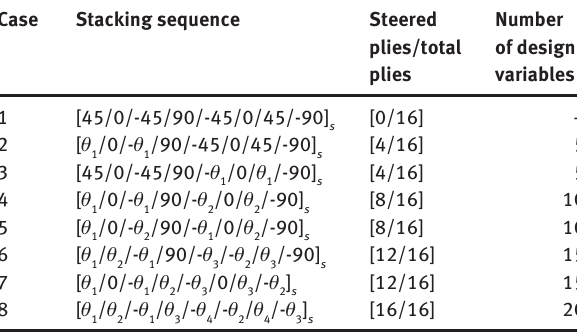
Table 2: VS laminates with different number of plies considered for fiber